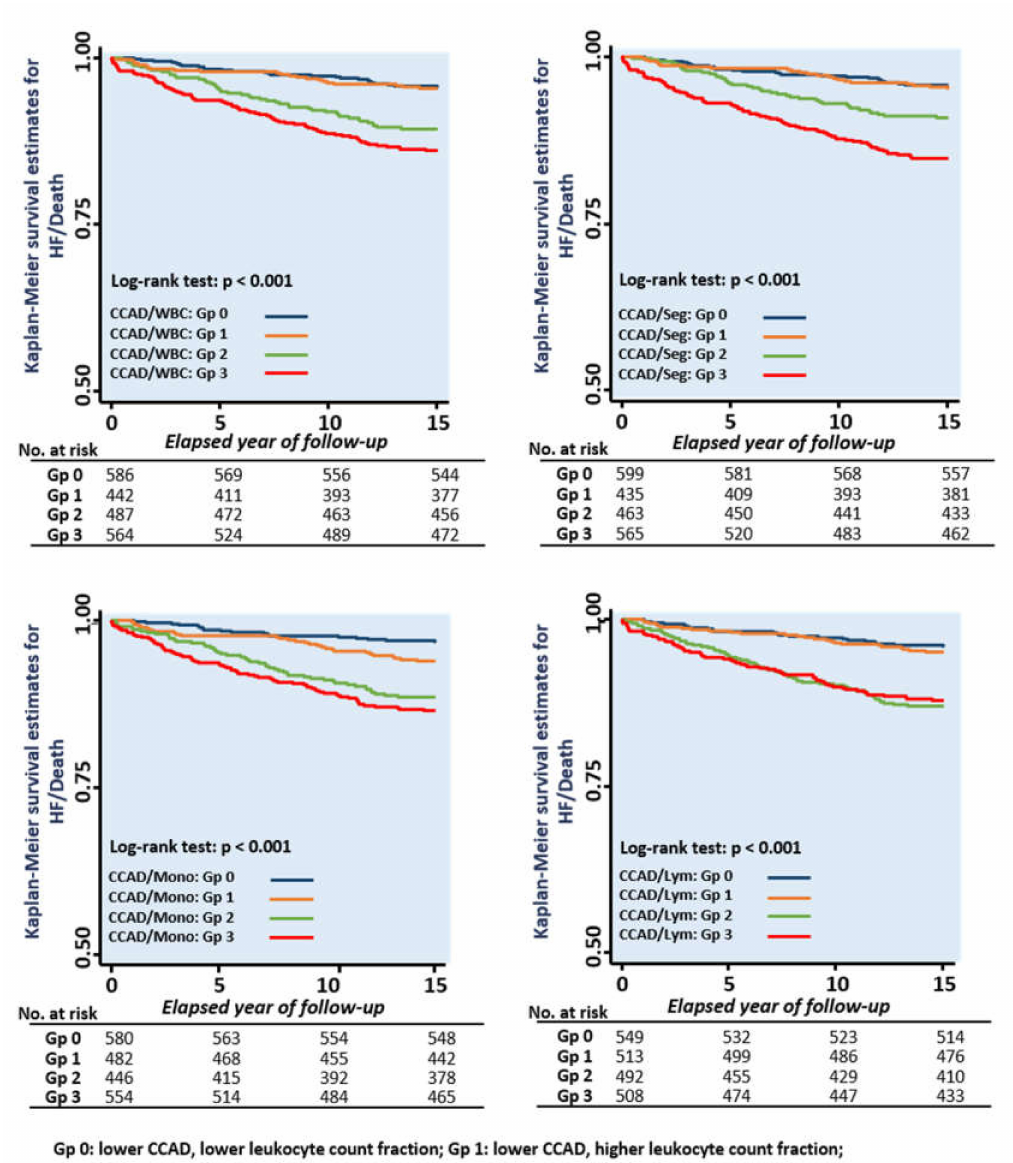
Figure 3. Kaplan–Meier curves demonstrating the associations of CCAD and various leukocyte count fraction categories (as lower and higher based on median values) with the composite HF and all-cause mortality